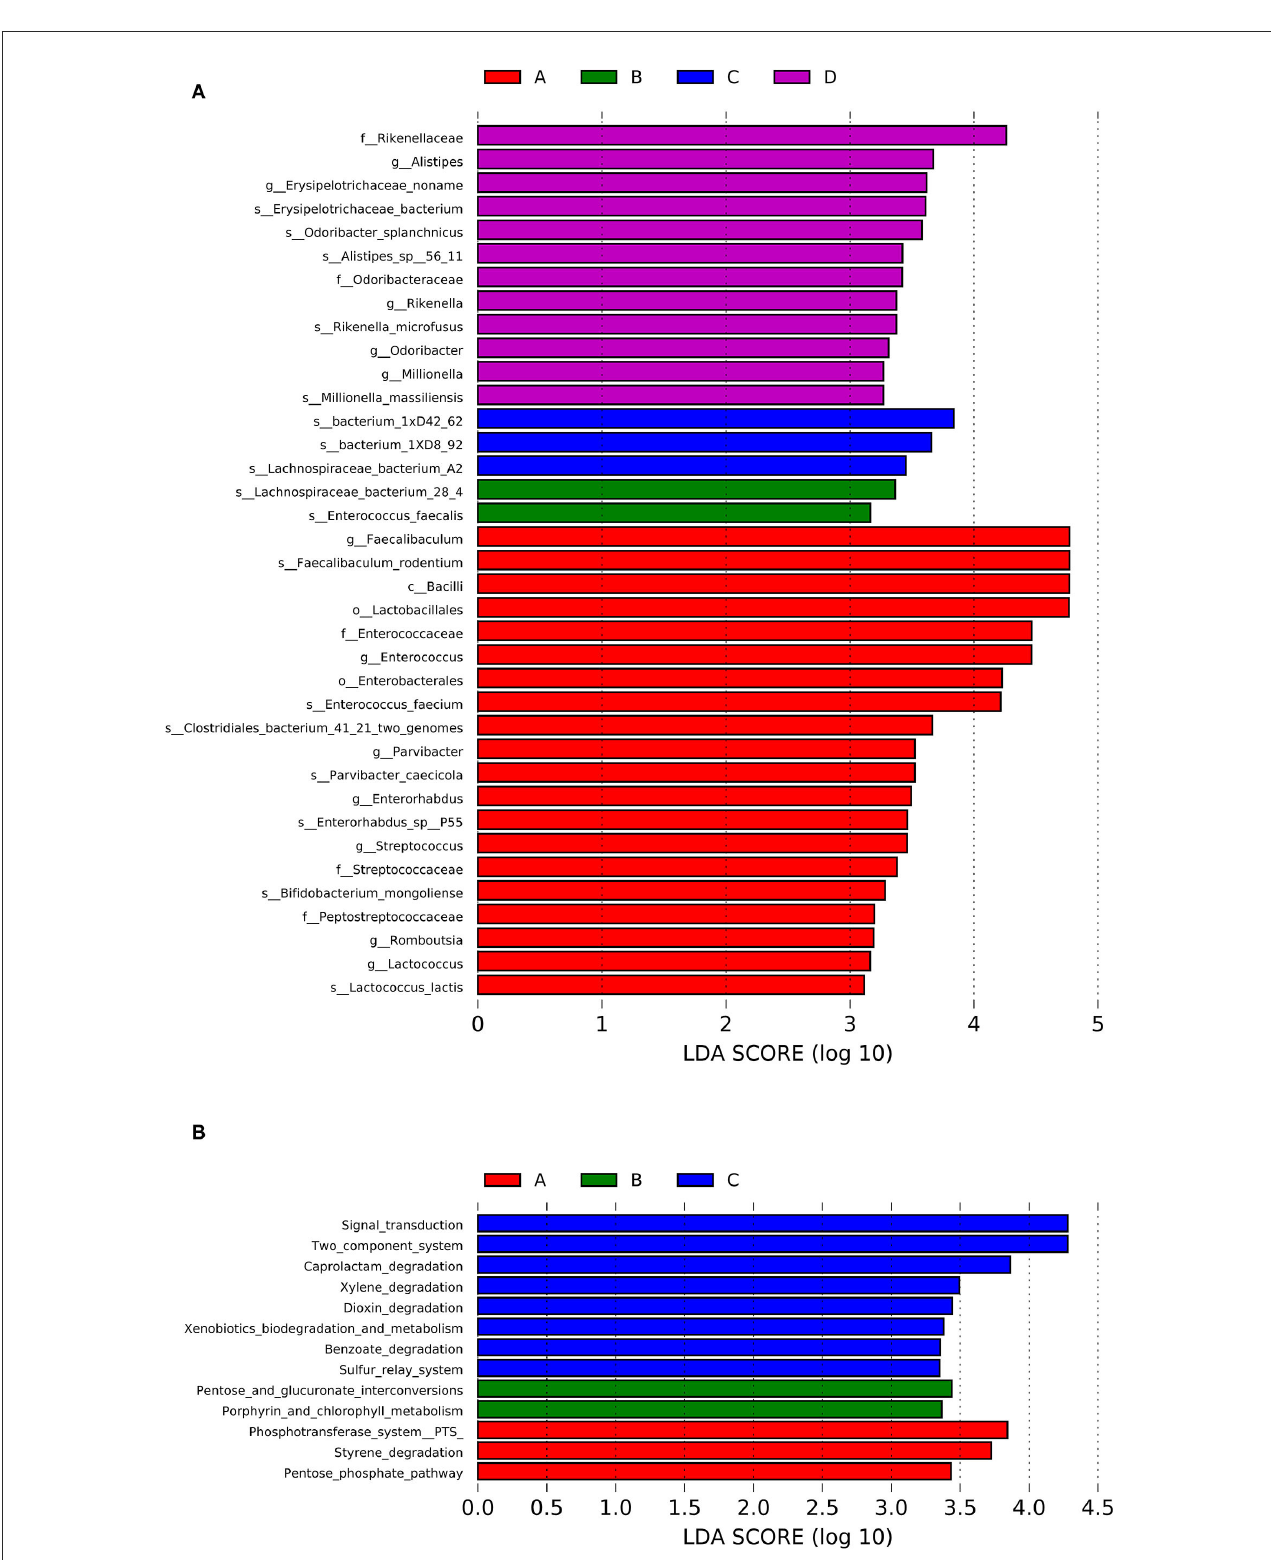
FIGURE4 LEfSe analysis of the differential relative abundances of the gut microbiota (A) and the KEGG enrichment pathways (B) for the four